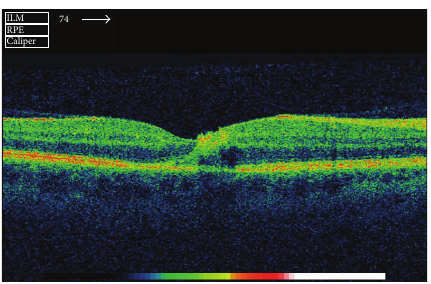
Figure 3: Spectral-domain optical coherence tomography scan of therightmaculapresentingintraretinalpseudocystandhyperreflec- tive deposits. ILM